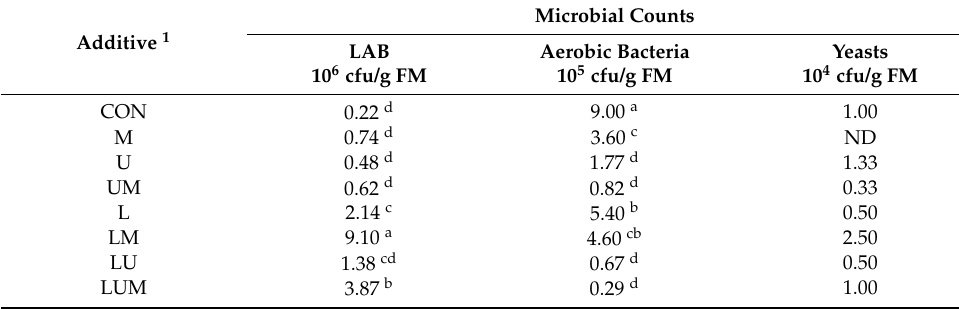
Table 4. Effect of cassava pulp by treated with Lactobacillus casei TH14 with urea and molasses on microbial population after 21 days of